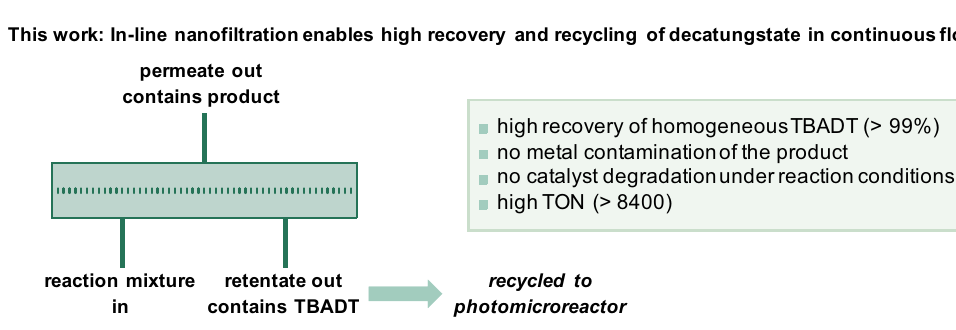
high molecular weight molecule resulting in a large mass fraction and thus high associatedcostwhendiscarded.Thiswarrantstheneedforcatalystrecycling. d We disclose a general and ef fi cient approach for decatungstate recycling using in-line nano fi